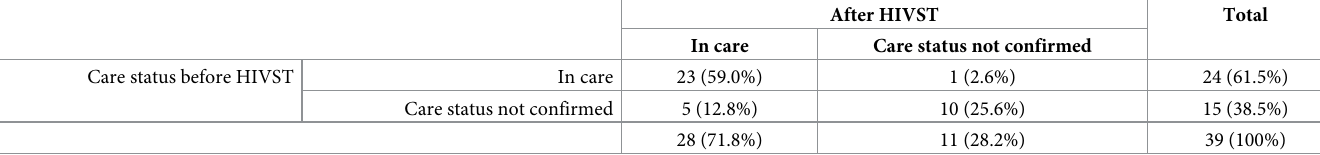
Table 3. Care status before and after HIVST among participants with previously-diagnosed HIV infection (N =